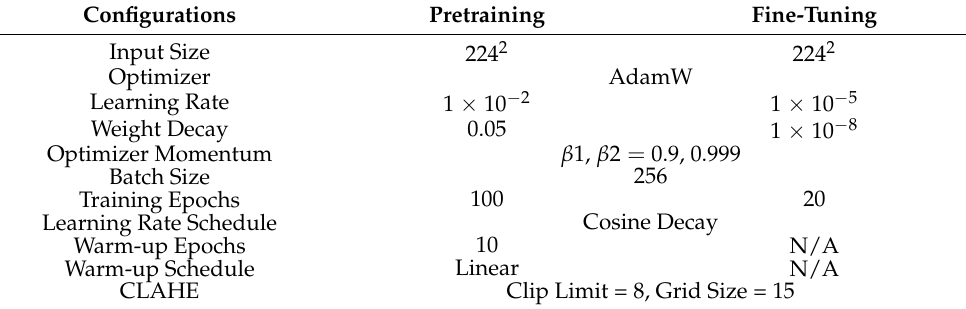
Table 5. Optimal hyperparameter values.